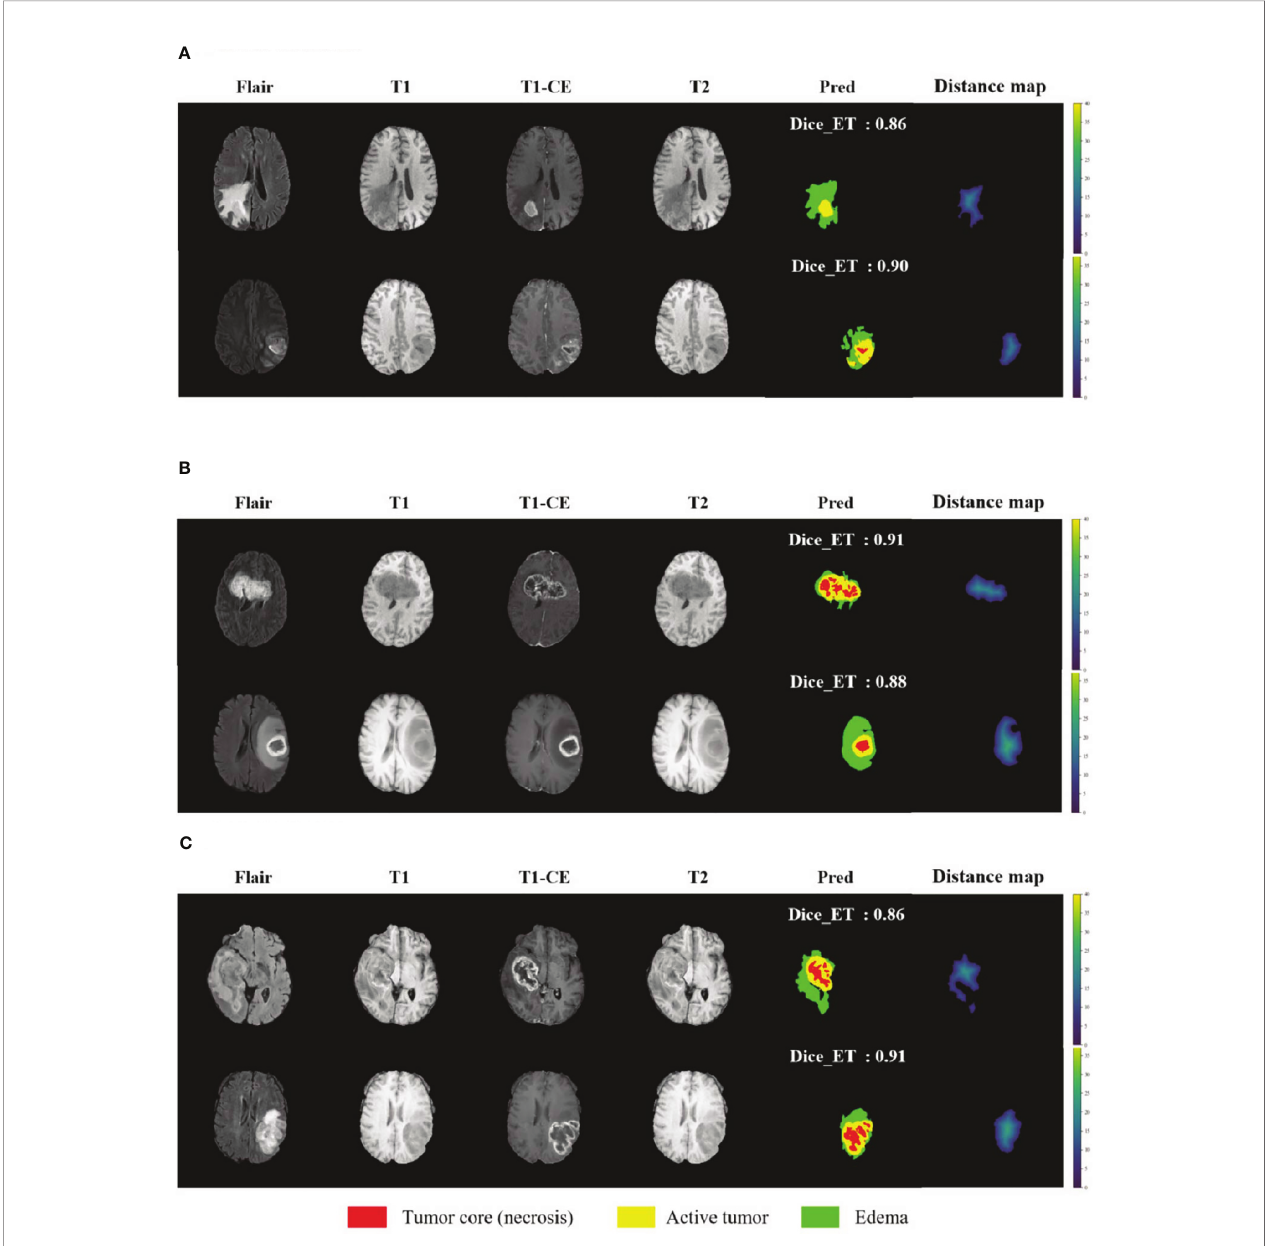
FIGURE 7 | Display of the segmentation results in validation set samples. (A) BraTS 2018 Data, (B) BraTS 2019 Data and (C) BraTS 2020 Data. Red color represents the tumor core (necrosis), yellow color represents the active tumor and green regions are the